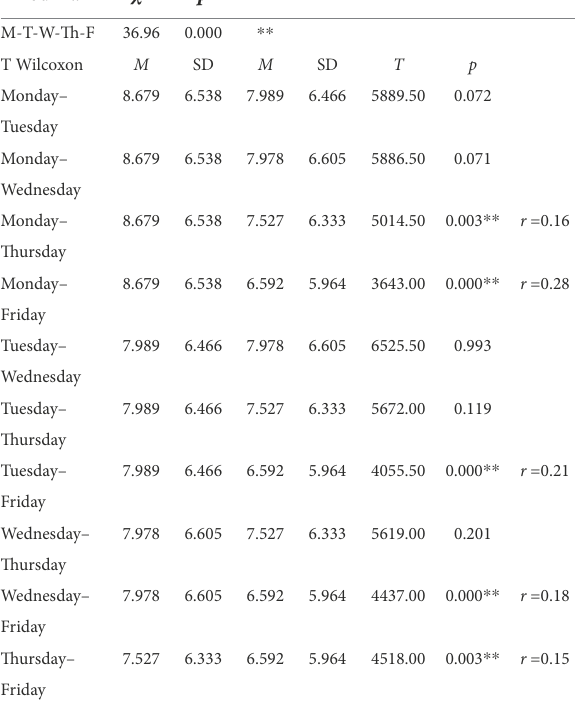
TABLE 7 Results of Friedman’s test and multiple a posteriori contrasts of interpersonal conflicts with peers in the school setting. Equal days of the week comparison